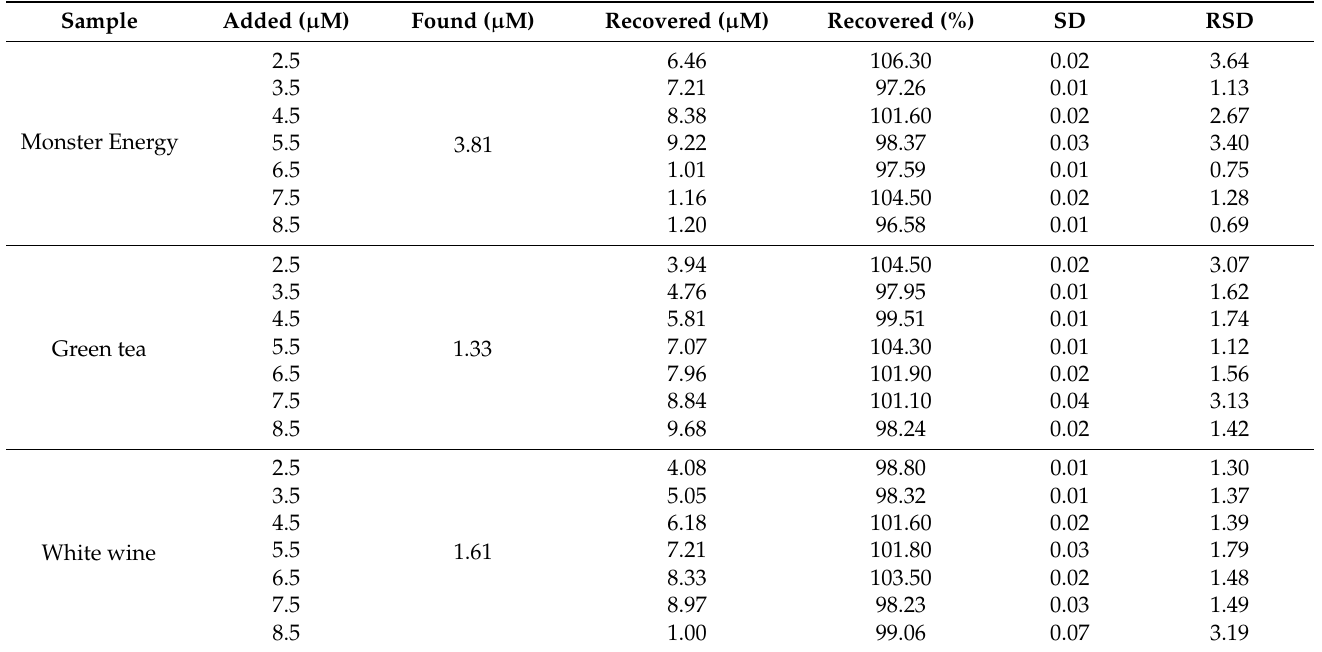
Table 3. Determination of RF in real